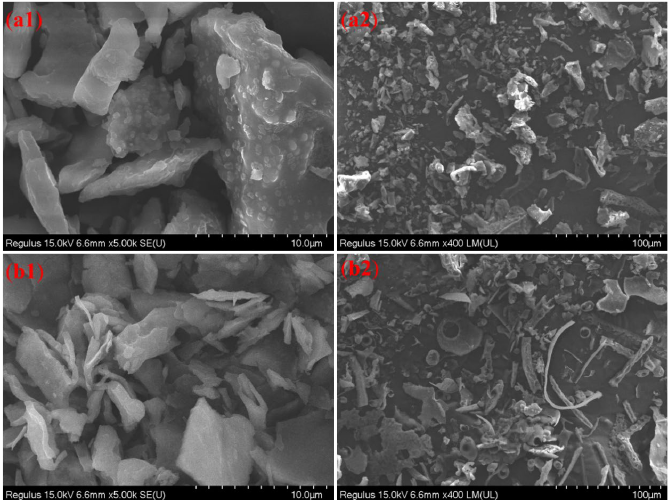
Figure 4. SEM images of GL1-E1 and GL1-E2. GL1-E1 images of different magnifications ( a1 : ×5000; a2 : ×400) and GL1-E2 images of different magnifications ( b1 : ×5000; b2 :